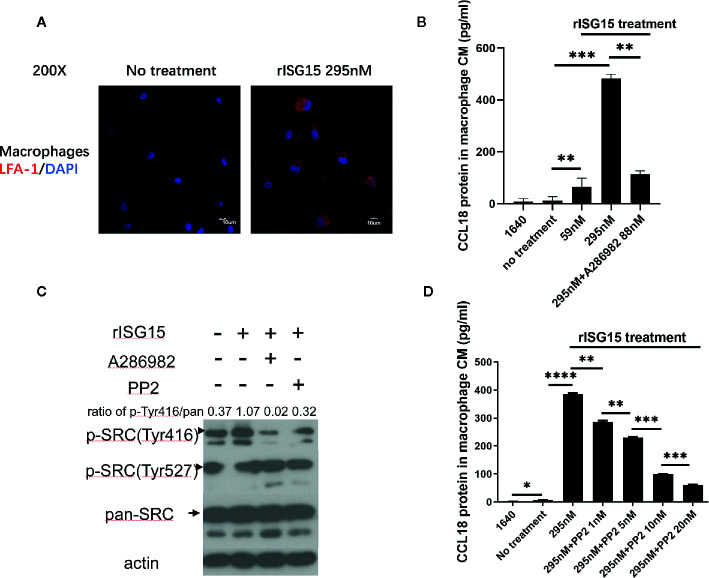
Interferon-stimulated gene 15 (ISG15)-induced CCL18 secretion by macrophages was dependent on the ISG15 receptor, leukocyte function-associated antigen-1 (LFA-1), and SRC family kinase (SFK) signaling. (A) Immunofluorescence demonstrated that the ISG15 receptor CD11a/CD18, also called LFA-1, was expressed on the membranes of human macrophages. Macrophages were treated with 295nM rISG15 for 24 h. Scale bars, 10 μm. (B) ELISA results showed small molecular inhibitors of LFA-1, A286982, inhibited CCL18 secretion by macrophages. (C) Small molecular inhibitors of LFA-1 and SRC, A286982 and PP2, hindered the ISG15-induced activation of SFK signaling. (D) PP2 reduced the CCL18 secretion by ISG15-treated macrophages in a dose-dependent manner, as determined by ELISA. *p < 0.05, **p < 0.01, ***p < 0.001, and ****p < 0.0001.